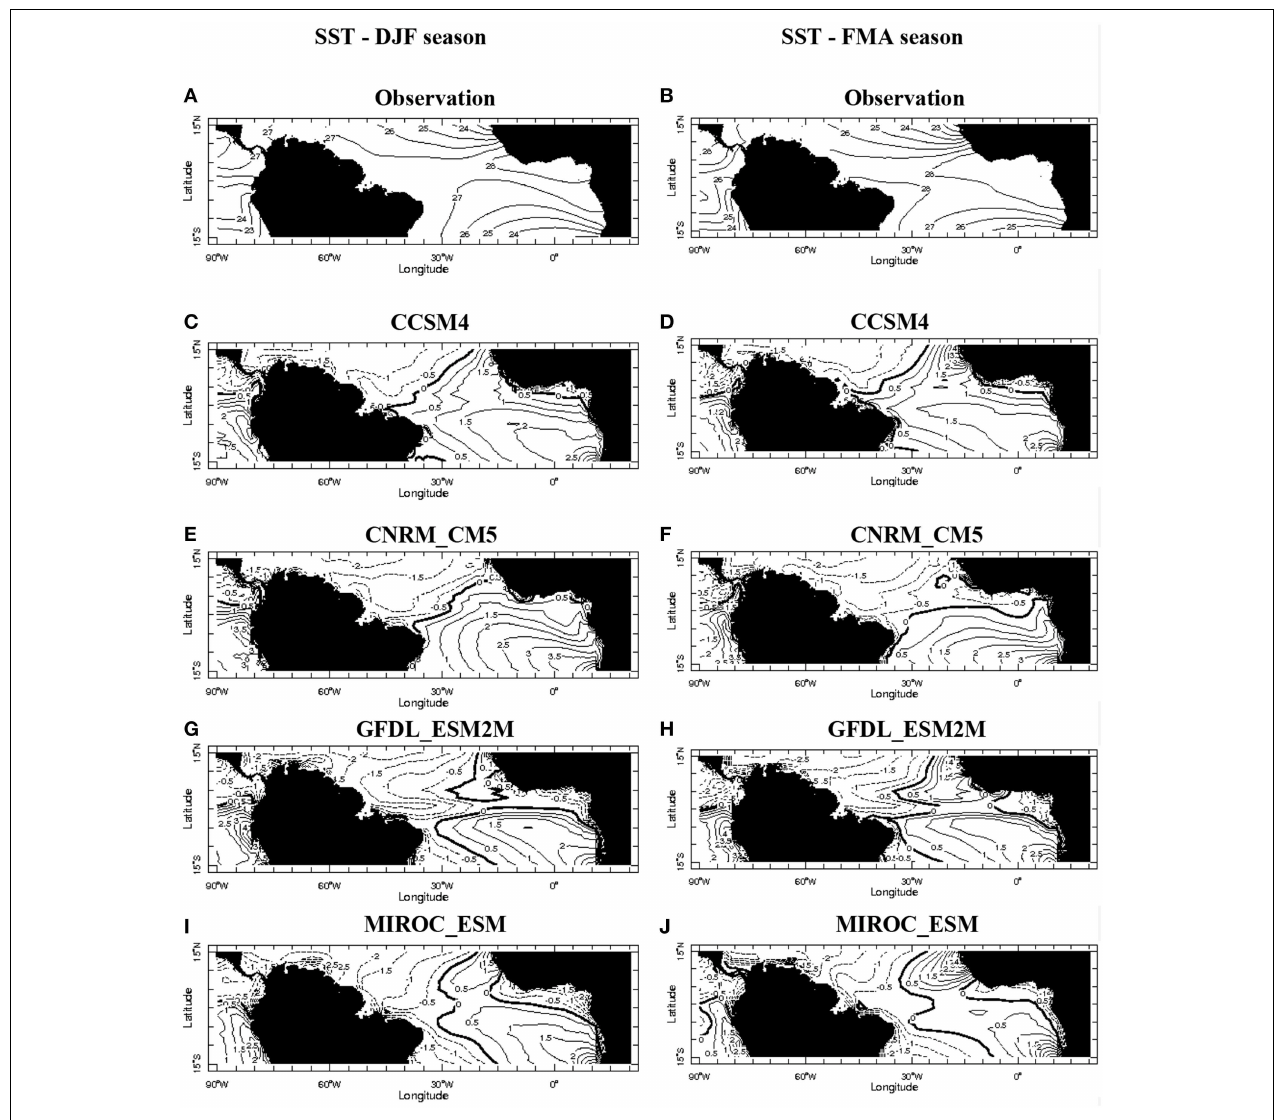
FIGURE 5 | Onthe leftpanelthe DJFmeanSSTduring 1963–2003 periodalongtheequatorareafortheobservation(letterA)andtheDJF anomaliesfortheCCSM4,CNRM_CM5, GFDL_ESM2M eMIROC_ESM models(lettersC,E,G,andIrespectively). Onthe rightpanelthe same